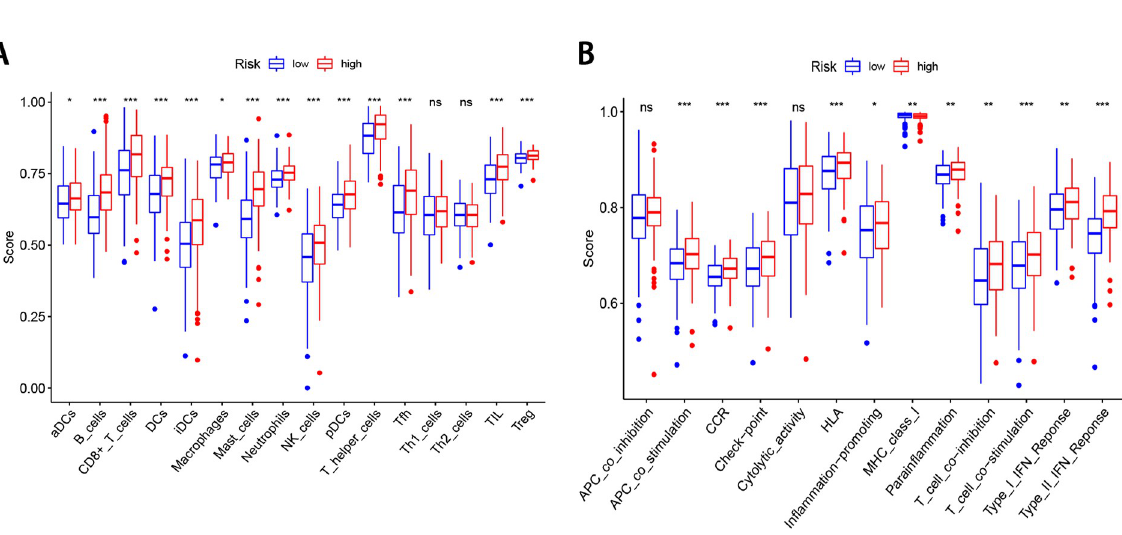
Fig 6. ssGSEA scores in the high- and low-risk patients in the TCGA cohort. The scores of 16 immune cells (A) and 13 immune-related functions (B) are displayed in boxplots.